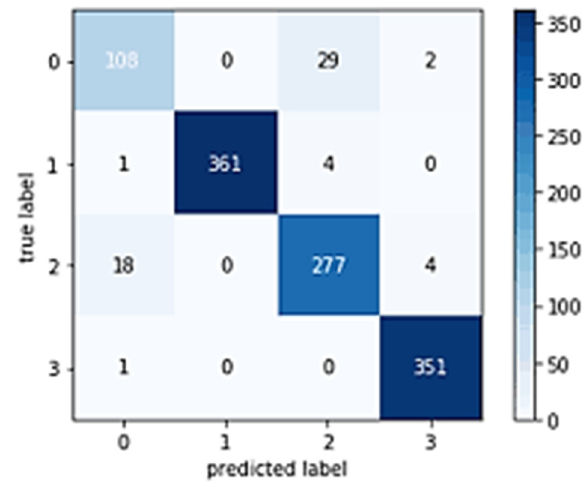
Figure 10. Confusion